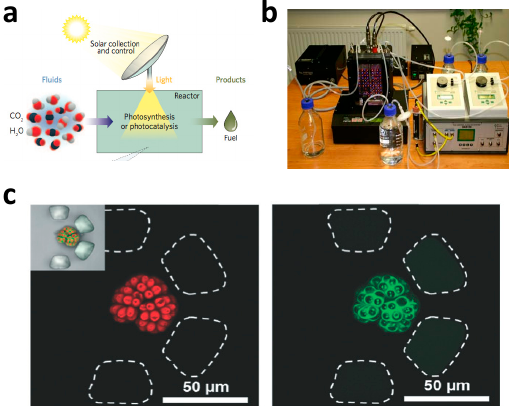
Figure 2. ( a ) Conceptual diagram of a photobioreactor [17]. The cyanobacteria convert CO 2 via photosynthesis to produce useful products such as biofuel . Reproduced with permission from Nature Photonics; published by Nature Publishing Group, 2011; ( b ) Picture of a commercial photobioreactor produced by Photo System Instruments [15]. The reactor has a volume of 400 mL and a sensor for optical density measurement; ( c ) Single Botryococcus braunii ( B. braunii ) colony trapping in the microfluidic photobioreactor array [19]. Reproduced with permission from Lab on a chip; published by Royal Society of Chemistry, 2014. Left and right panels show the autofluorescence from cholorophyll and lipid-stained images after Nile red treatment.